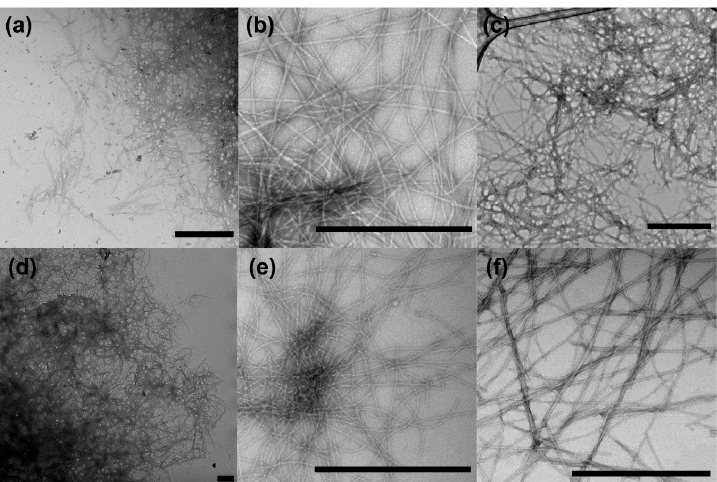
Figure 1. Negatively stained transmission electron micrographs of pathogenic and functional amyloid fibrils. ( a ) α -Synuclein fibers. ( b ) A β 1-40 fibrils. ( c ) Amylin fibrils. ( d ) Curli fibrils. ( e ) HET-s 218-289 fibrils. ( f ) IIKIIK fibrils associated with PSM α . Scale bars represent 200 nm. Published with permission from Robert Tycko and Neha Jain.